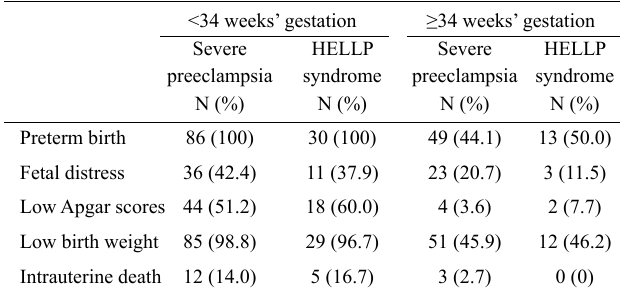
TABLE 3. Perinatal